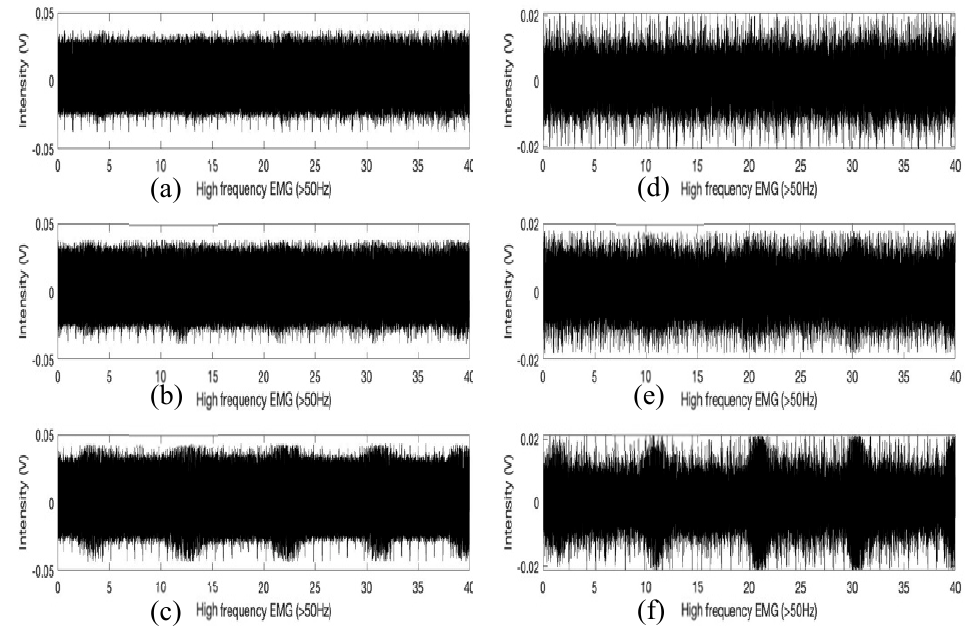
Figure 5. The EMG signal above 50 Hz were recorded at 4 kHz sampling frequency. The experiments were conducted to have the same 2-s inspiration, 2-s expiration, 5-s pause cycle breathing pattern from diaphragm location ( a – c ) and the EIM location ( d – f ): ( a ) 500 mL tidal volume; ( b ) 750 mL tidal volume; ( c ) 1000 mL tidal volume; ( d ) 500 mL tidal volume; ( e ) 750 mL tidal volume; ( f ) 1000 mL tidal volume.